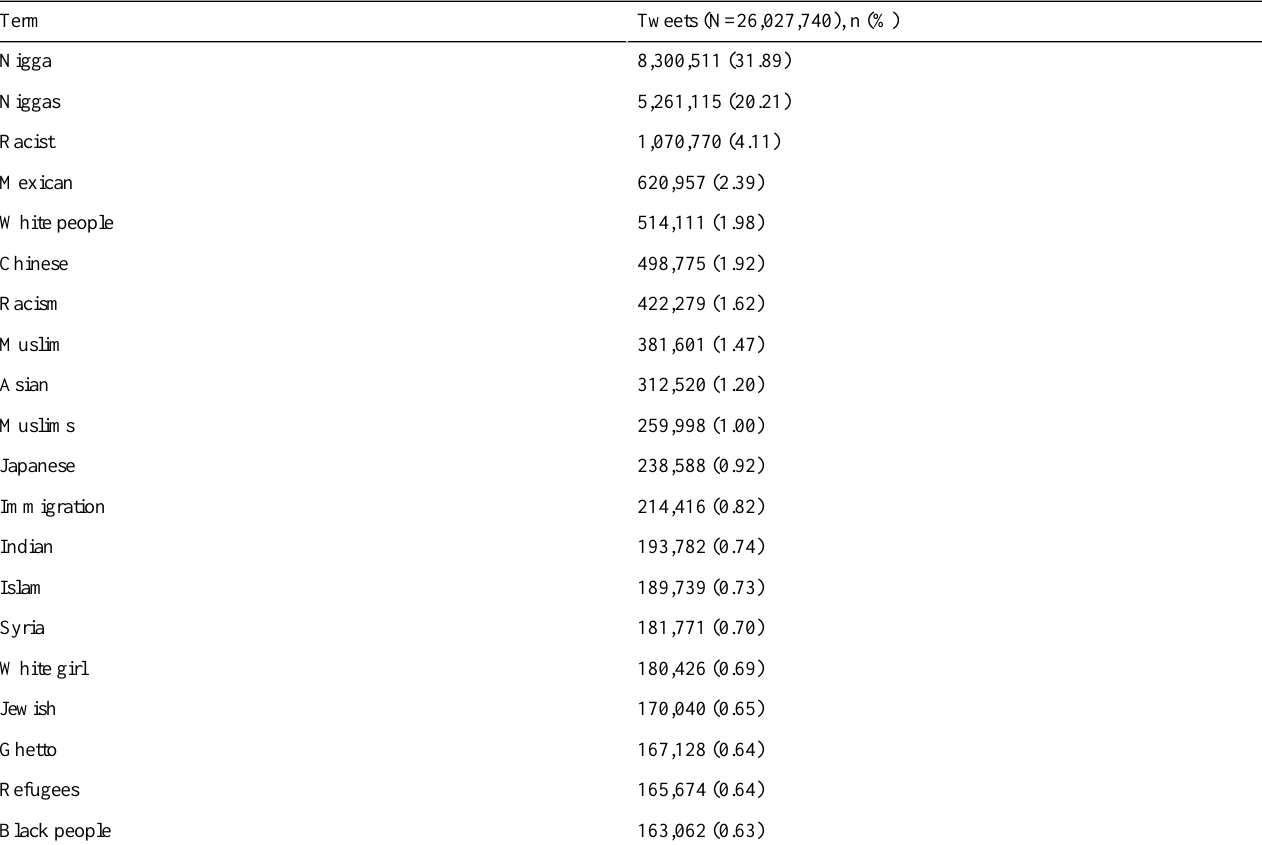
Table 1. Top Twitter